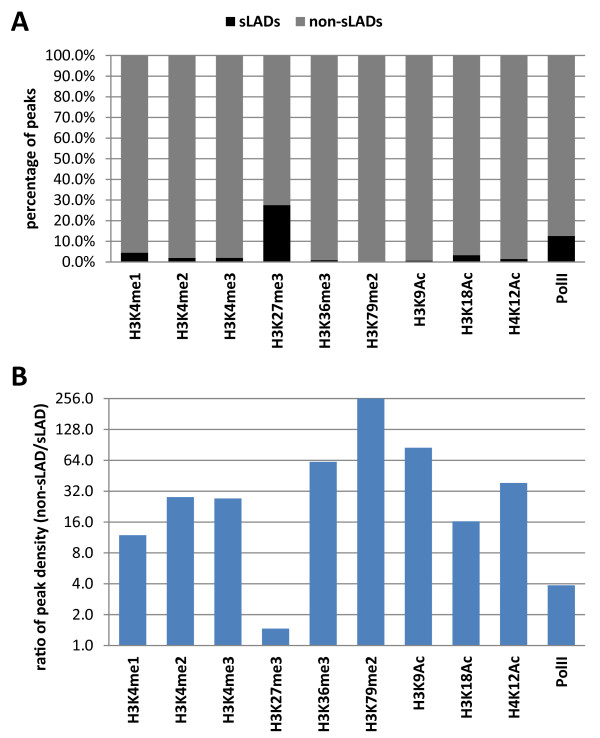
Distributions of histone modifications and Pol II relative to sLADs in C2C12 myoblasts. (A) Proportions of ChIP-seq peaks of histone modifications and Pol II within sLADs (black) or within non-sLADs (grey) according to the peak center. ChIP-seq peaks were obtained from [35,37]. (B) Ratios of ChIP-seq peak densities in non-sLADs to those in sLADs for each histone modification and Pol II. The peak densities in sLADs and in non-sLADs were computed as the ChIP-seq peak number divided by the genome coverage. Peak density ratios were plotted in the log2 scale at the vertical axis.